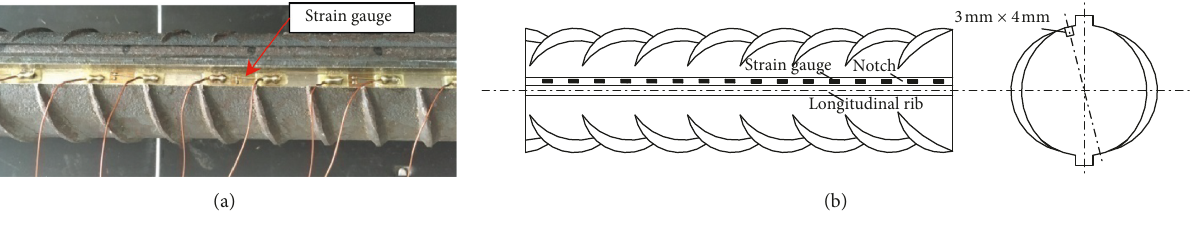
Figure 5: Strain gauges attached along the notch. (a) Photograph. (b) Schematic.